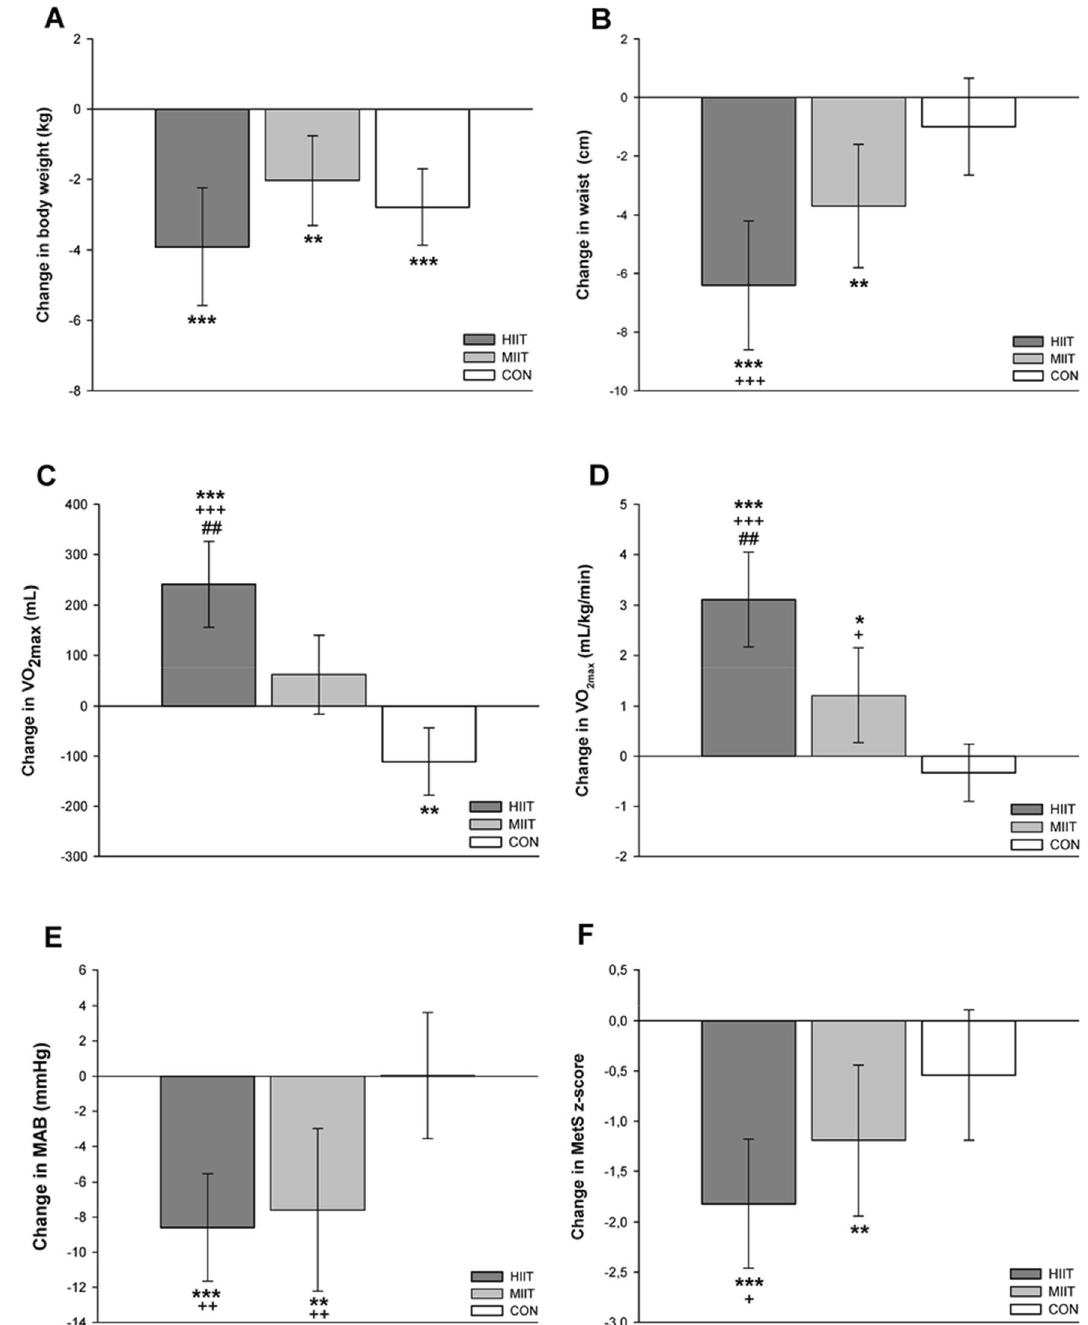
Figure 2. Changes in body weight (A) , waist circumference (B) , absolute maximal oxygen uptake (C) , relative maximal oxygen uptake (D) , mean arterial blood pressure (E) , and metabolic syndrome z-score (F) . HIIT, high- intensity interval training group; MIIT, moderate-intensity interval training group; CON, control group; VO 2max , maximal oxygen uptake; MAB, mean arterial blood pressure; MetS, metabolic syndrome. *( p < 0.05), **( p < 0.01), ***( p < 0.001), significantly different from pre-intervention. + ( p < 0.05), ++ ( p < 0.01), +++ ( p < 0.001), significant difference vs. CON; ## ( p < 0.01), significant difference vs.